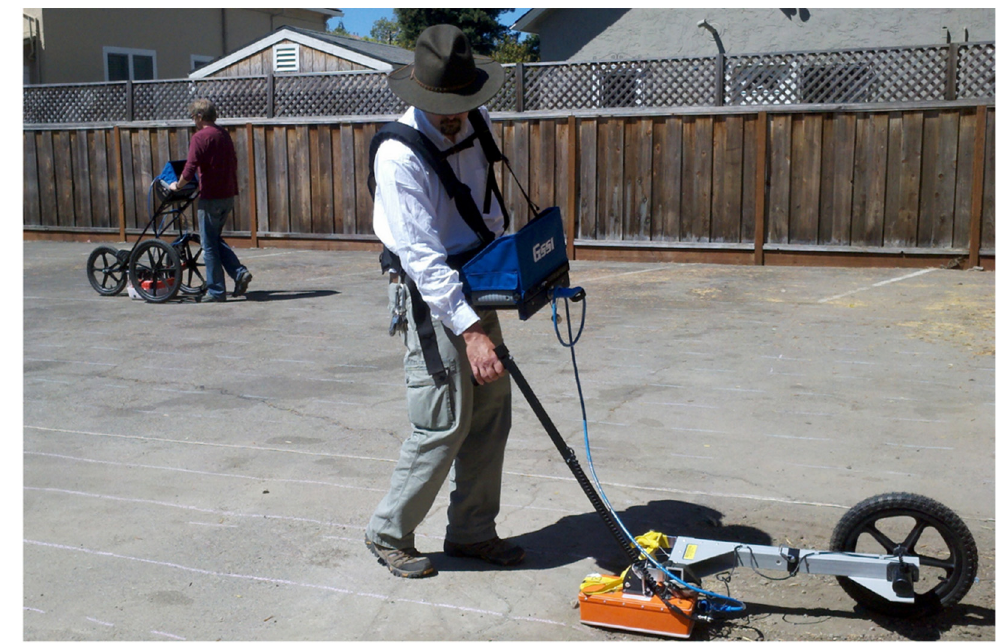
Figure 3. Scanning simultaneously with multiple antennae resolutions and offset grids.